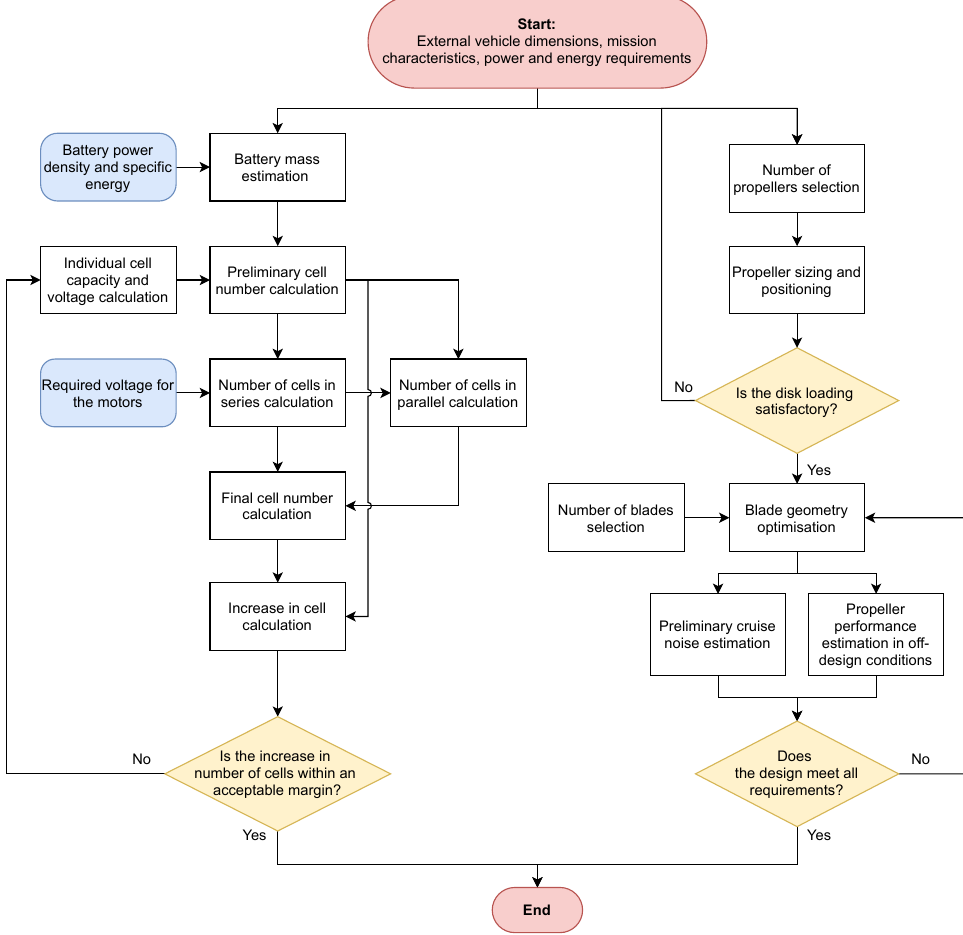
Figure 2. Flowchart of the propulsion and power systems design procedure presented in this